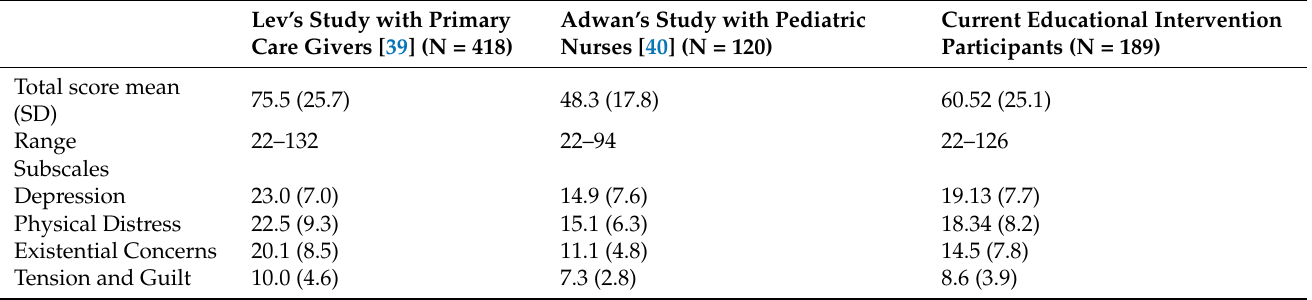
Table 3. Revised Grief Experience Inventory (RGEI)